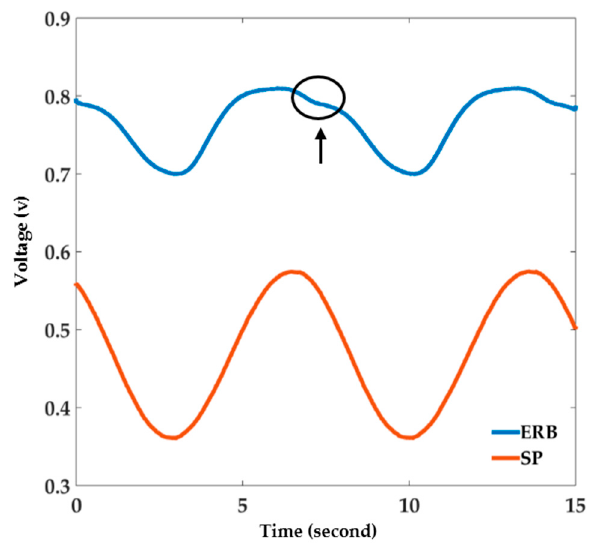
Figure 2. ERB voltage versus SP voltage for one recording. The circled area highlights the ERB contraction nonlinearity.